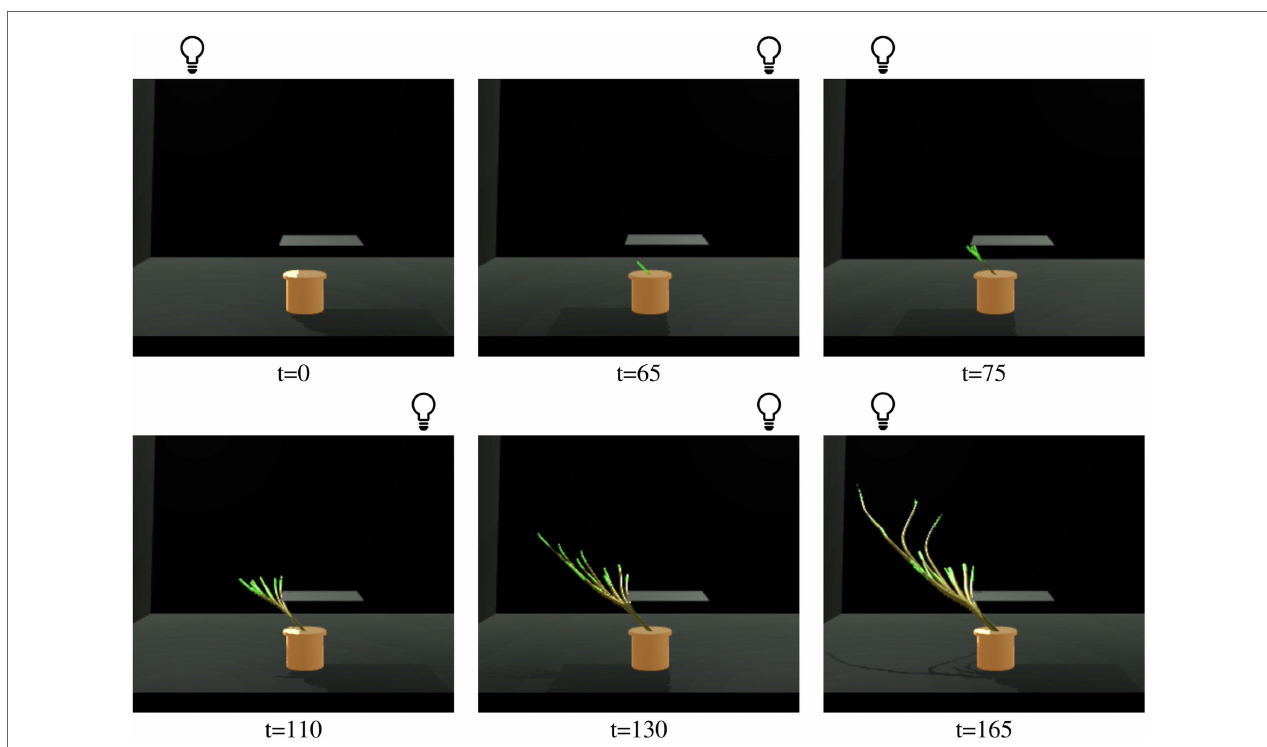
FigUre 7 | Screenshots of a swarm grammar specifically illustrating shadow avoidance. The plate hovering above the plant pot effectively shields the light from the top-right light source (depicted as a sphere). Avoiding the shadow, the plant’s growth is dominated by a sidesways